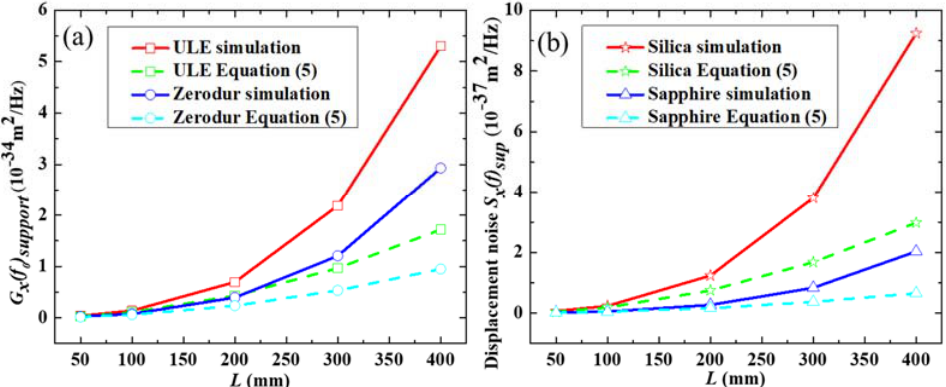
Figure 6. TN of the four support pads as functions of the spacer length L . The red solid line with squares and the green dashed line with squares denote the FEA simulation results and the estimated results of the all-ULE USC, respectively. The blue solid line with circles and the light blue dashed line with circles denote the FEA simulation results and the estimated results of the all-zerodur USC, respectively. The red solid line with stars and the green dashed line with stars denote the FEA simulation results and the estimated results of the all-silica USC, respectively. The blue solid line with triangles and the light blue dashed line with triangles denote the FEA simulation results and the estimated results of the all-sapphire USC, respectively. ( a ) Room-temperature materials. ( b ) Low-temperature materials.